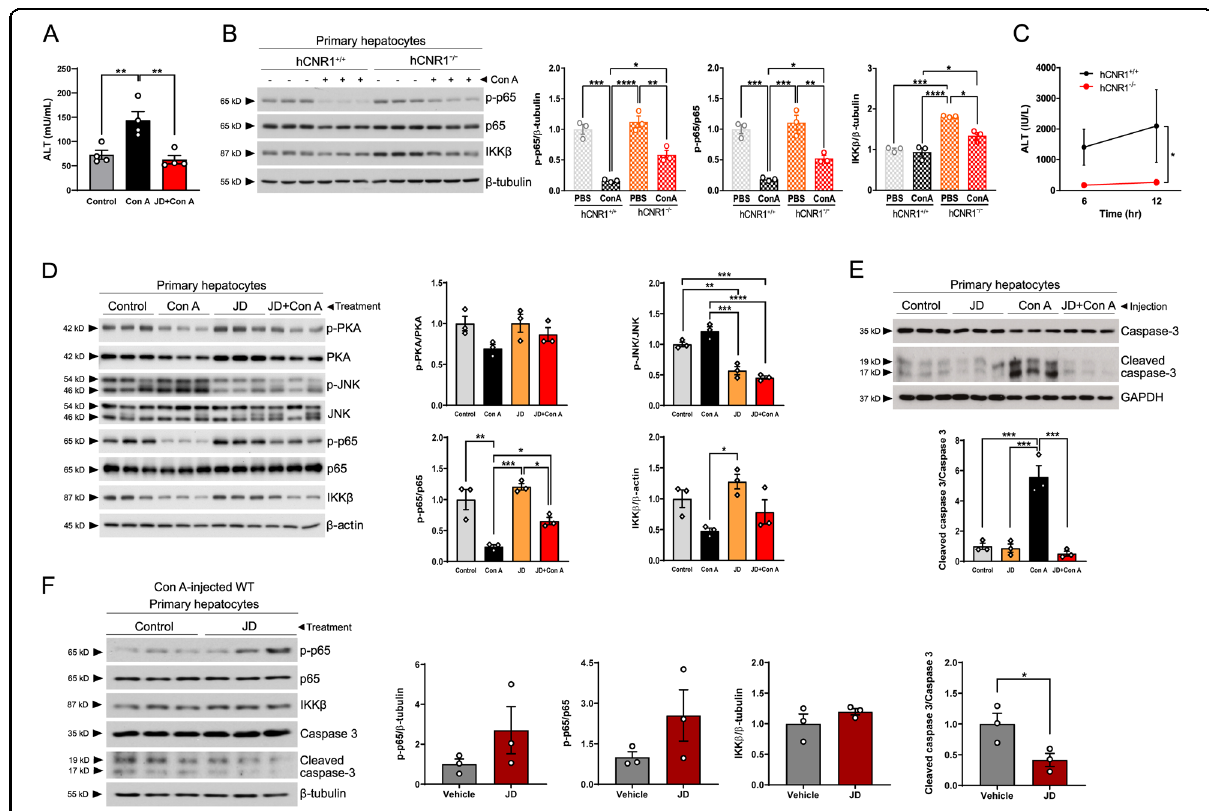
Fig. 6 Hepatocyte-speci fi c CB1R plays a pivotal role in response to in fl ammation. A Serum alanine aminotransferase (ALT) levels (mU/mL) in Con A-administered wild-type mice ( n = 4 per each group). C57BL/6J background mice were injected intraperitoneally with vehicle (DMSO) or